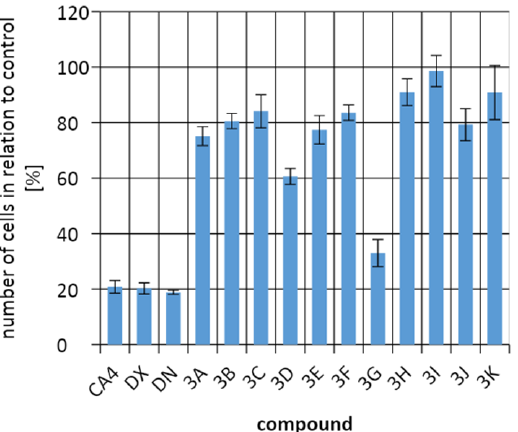
Figure 9. Comparing the number of cells from line A549 in relation to the control culture.